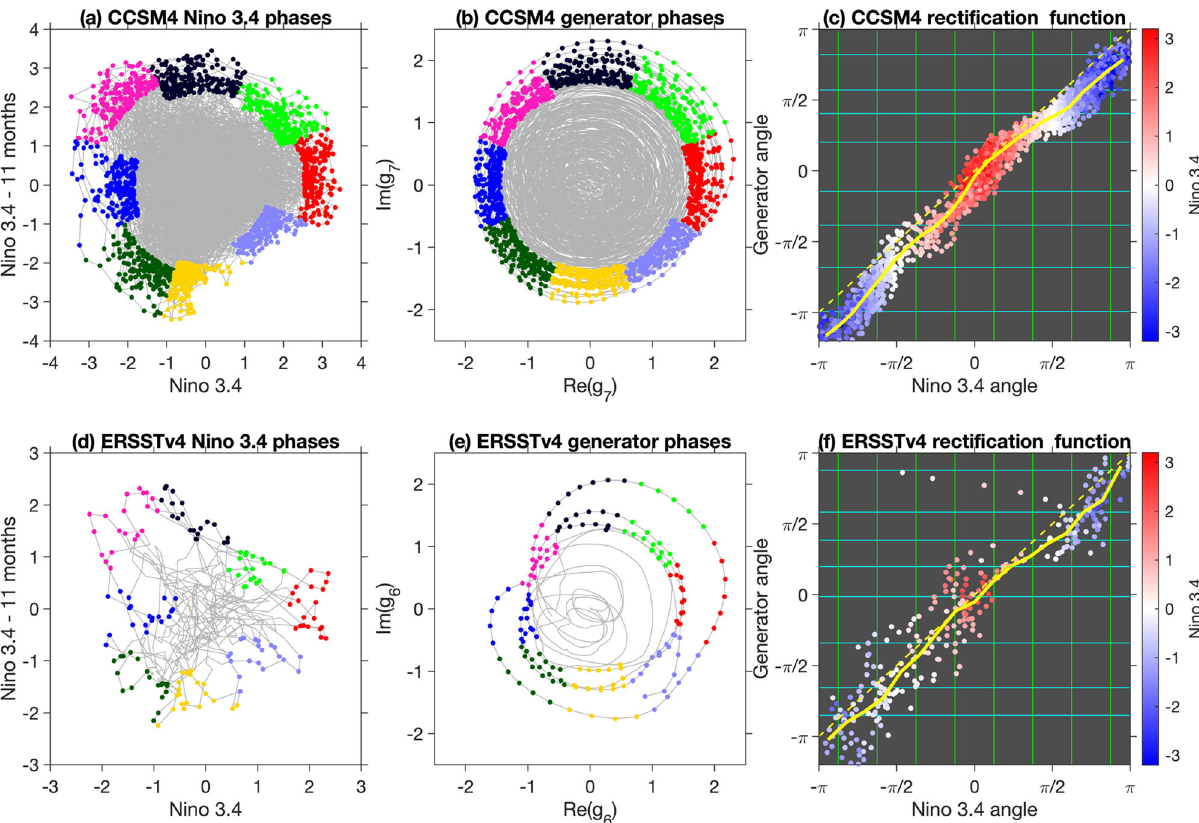
Fig. 6 ENSO phases for CCSM4 (a, b) and ERSSTv4 (d, e), identi fi ed using lagged Niño 3.4 indices f nino (a, d) and generator eigenfunctions g j (b, e). Phases are selected by partitioning the 2D phase space into eight angular sectors of uniform angular extent (equal to 45 ∘ ), and then selecting the samples with the m largest distances (corresponding to ENSO amplitudes) from the origin in each sector. We use m = 200 and m = 20 for CCSM4 and ERSSTv4, which corresponds to ~1.5% and 3% of the available data per phase, respectively. The selected data points in each phase are marked by distinct colors, with red corresponding to the El Niño phase, Phase 1. Progression from Phase 1 to Phase 8 takes place in a counter-clockwise sense. The La Niña phases in the Niño 3.4 and generator representation are Phases 5 (blue) and 4 (pink), respectively. Gray lines show the phase space evolution over the entire 1300-year ( a , b ) and 50-year ( d , e ) analysis intervals. c and f The recti fi ed generator angle ( y -axis) against the Niño-3.4 angle ( x -axis). The yellow curves fi t the data points and by construction pass through the origin (0,0), which corresponds to El Niño for both the Niño-3.4 and generator representations. Note that according to the yellow curve in c , El Niño for the Niño-3.4 representation, occurring at angle π on the x -axis, corresponds to an angle of ≈ 3 π /4 on the y - axis for the recti fi ed cycle. This quanti fi es the more rapid transition between El Niño and La Niña in CCSM4, in comparison to the reverse transition. Although less noticeable in the yellow curve in f , the ERSSTv4 results display a similar El NiñoLa Niña transition asymmetry, manifested by the tendency of La Niñas (dark blue dots) to occur below the diagonal dashed line. The speed of transition is indicated at the fi ner level of phases by the green lines, which are spaced equally on the x -axis according to Niño-3.4 phase boundaries. Wider (resp. narrower) spacing of the horizontal green lines corresponds to a slower (resp. faster) transition between